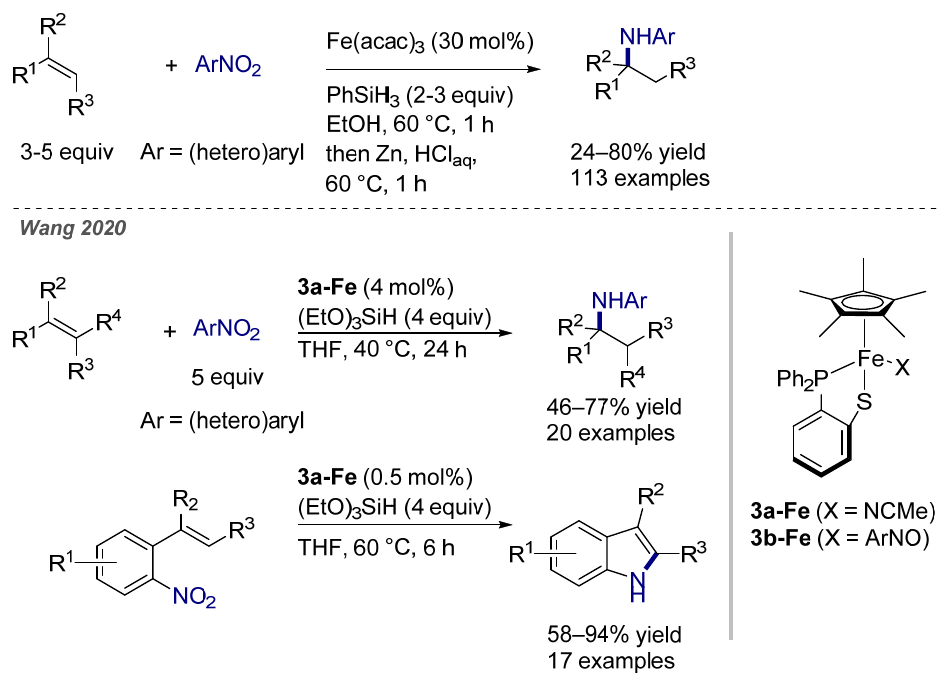
Figure 9. Inter and intramolecular Fe-H-promoted formal hydroamination of nitro (hetero)arenes and alkenes.